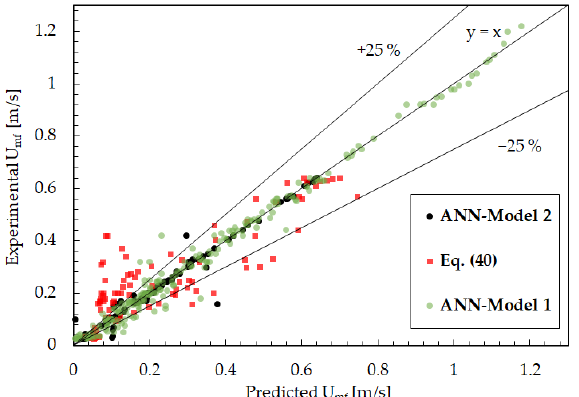
Figure 3. Comparison among experimental and predicted values of U mf to the mixtures.